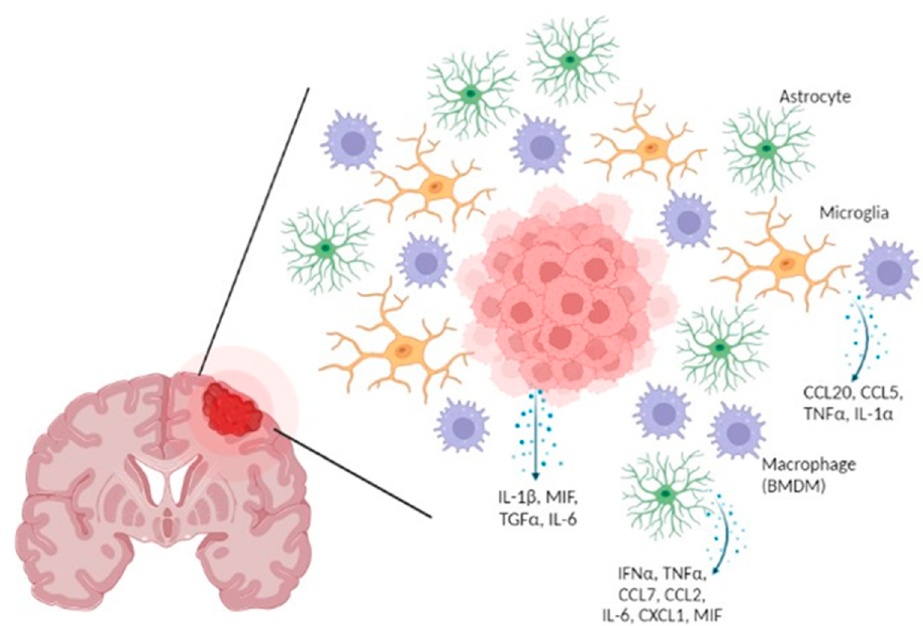
Figure 2. Pattern of cytokines which are released during brain metastasis establishment. Cancer cells (red) release several cytokines such as IL-6, IL-1 β , TGF α and MIF in the brain leading to the activation of astrocytes (green) and macrophages (violet)/microglia (yellow) that secrete multiple cytokines and chemokines to support tumor growth [43,45,47–49,52–54]. Figure created with Biorender.